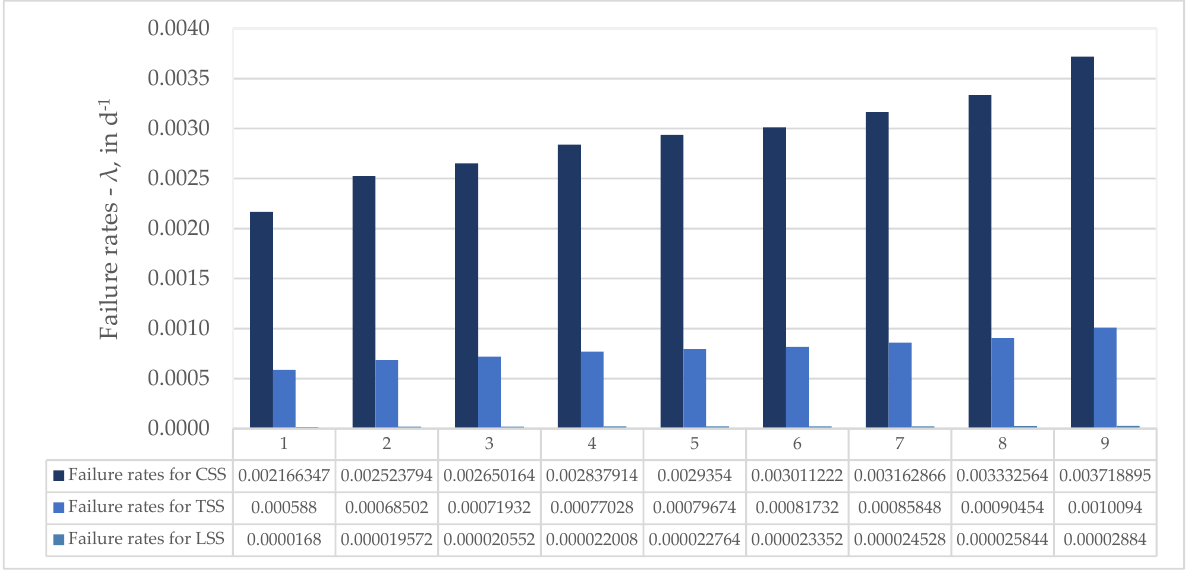
Figure 2. Failure rates for λ CSS, λ TSS, and λ LSS .